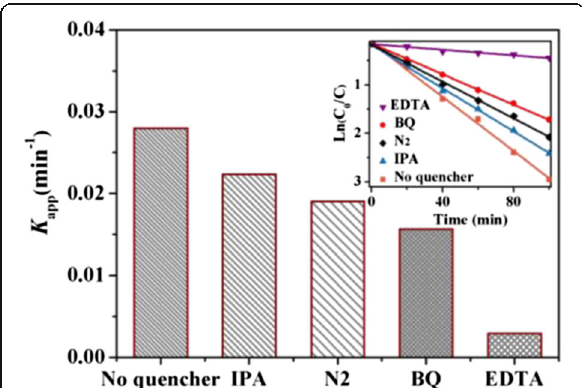
Fig. 9 Rate constant k app of the WS 2 /Bi 2 MoO 6 (5 wt%) composite for the degradation of RhB in the presence of different scavengers under visible-light irradiation